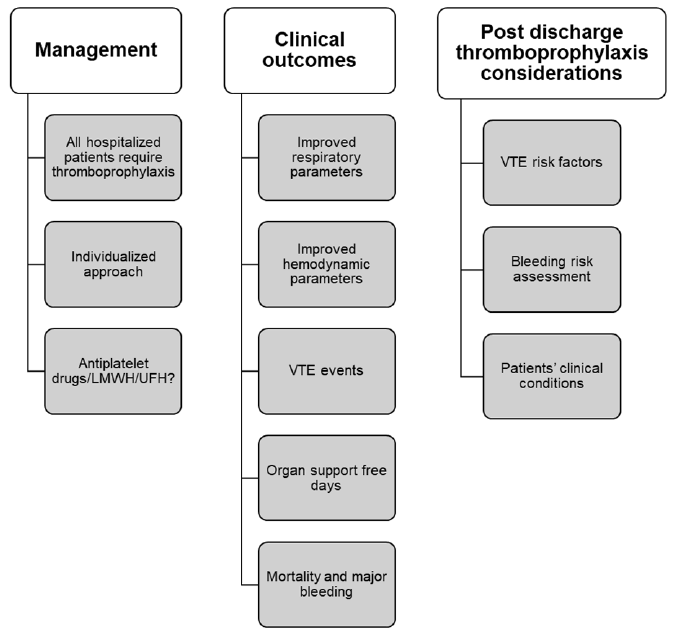
Figure 2. Management of VTE in-hospital and post-discharge [33,81]. LMWH, Low-molecular- weight heparins; UFH, unfractionated heparin; VTE, venous thromboembolism. Box 3. Dose and duration of thromboprophylaxis.